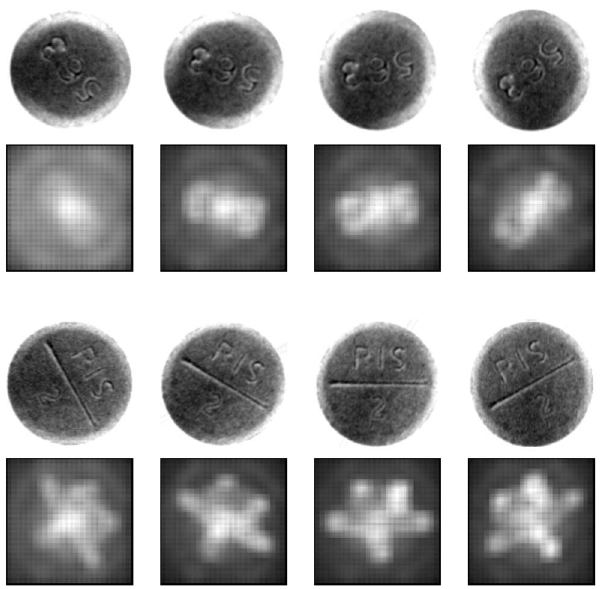
Figure 14. Cell weight visualization for different rotation angles. Higher intensity values represent higher